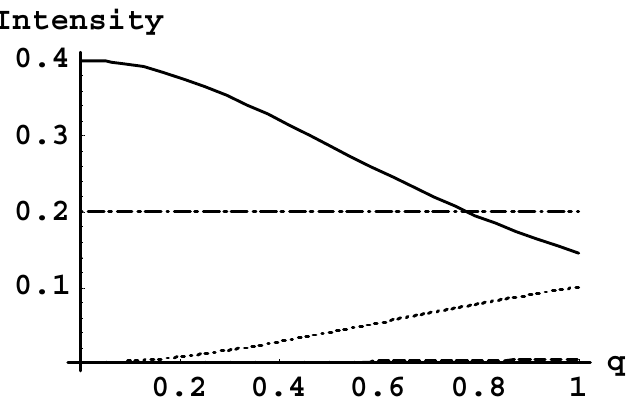
Figure 24. Relative intensities of the Ly-alpha line components versus the parameter q (given by Equations (12.15) and (12.16). Intensities of the components having the central frequencies ± [(1 + q 2 ) 1/2 − 1], ± [(1 + q 2 ) 1/2 + 1], ± 1, and 0 are shown by solid, dashed, dotted, and dash-dotted lines, respectively. The sum of relative intensities of all components is set to unity [150].